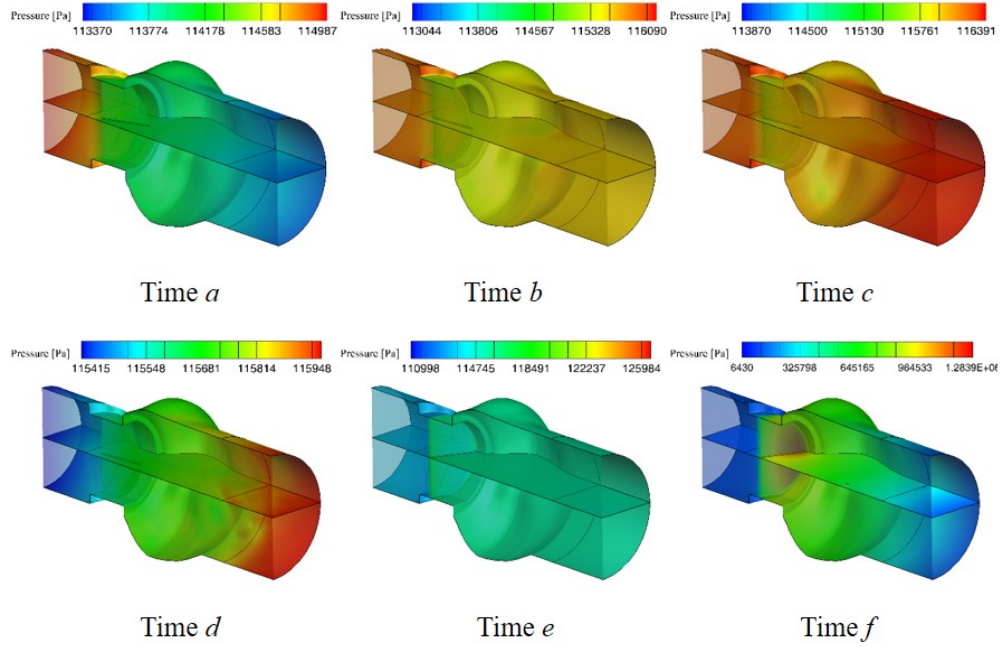
Figure 6. The variation of pressure in the channel.